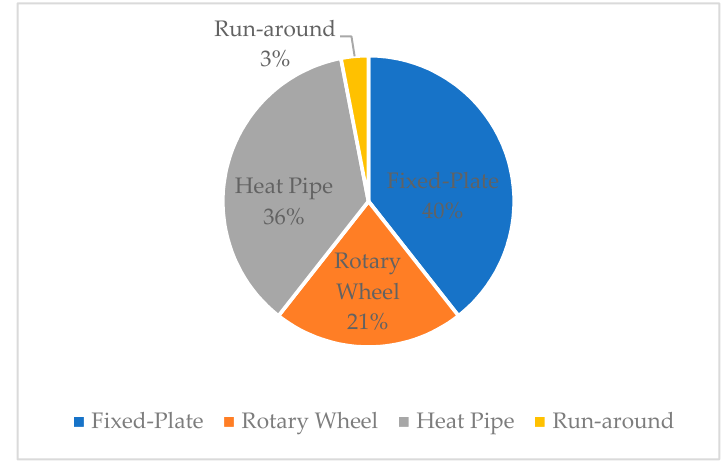
Figure 10. Heat recovery system research article distribution.